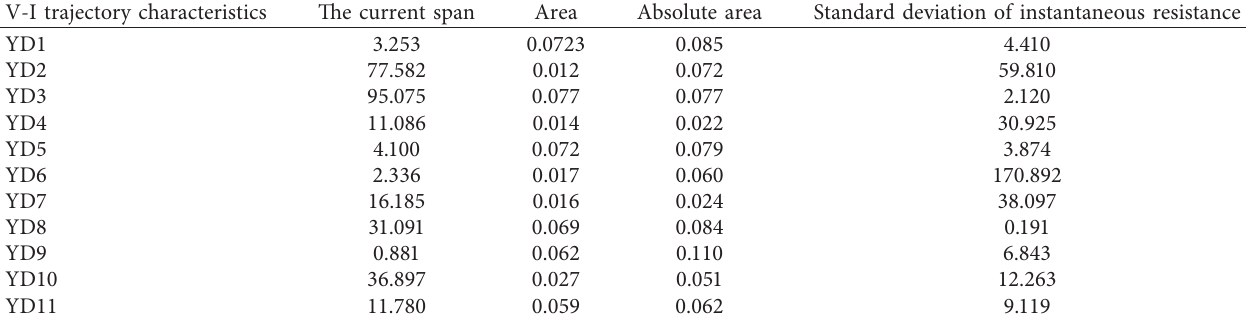
Table 3: The V-I trajectory characteristics of gear 1 of each